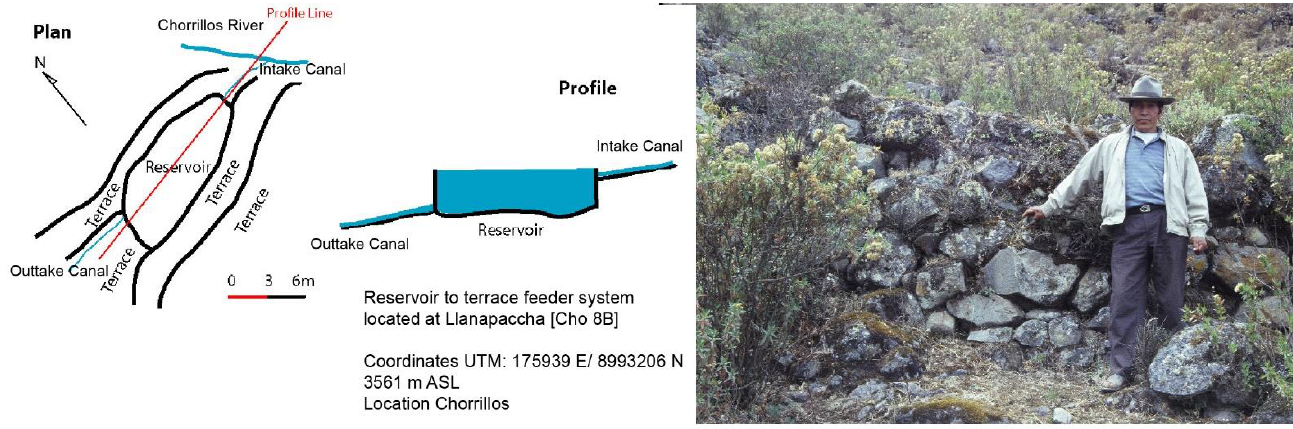
Figure 14. Right image — Bench terraces of Cho 8B Llanapaccha; Left image — Plan of reservoir and bench terraces at Cho 8B Llanapaccha.